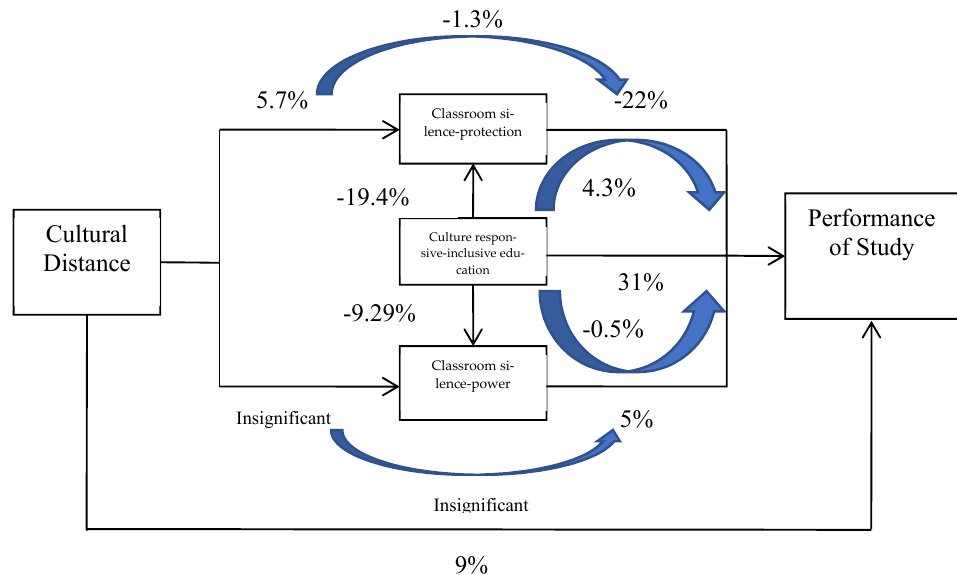
Figure 2. Simulation of the direct and indirect effects of cultural distance and CRIE on study perfor- mance (% standard deviation).